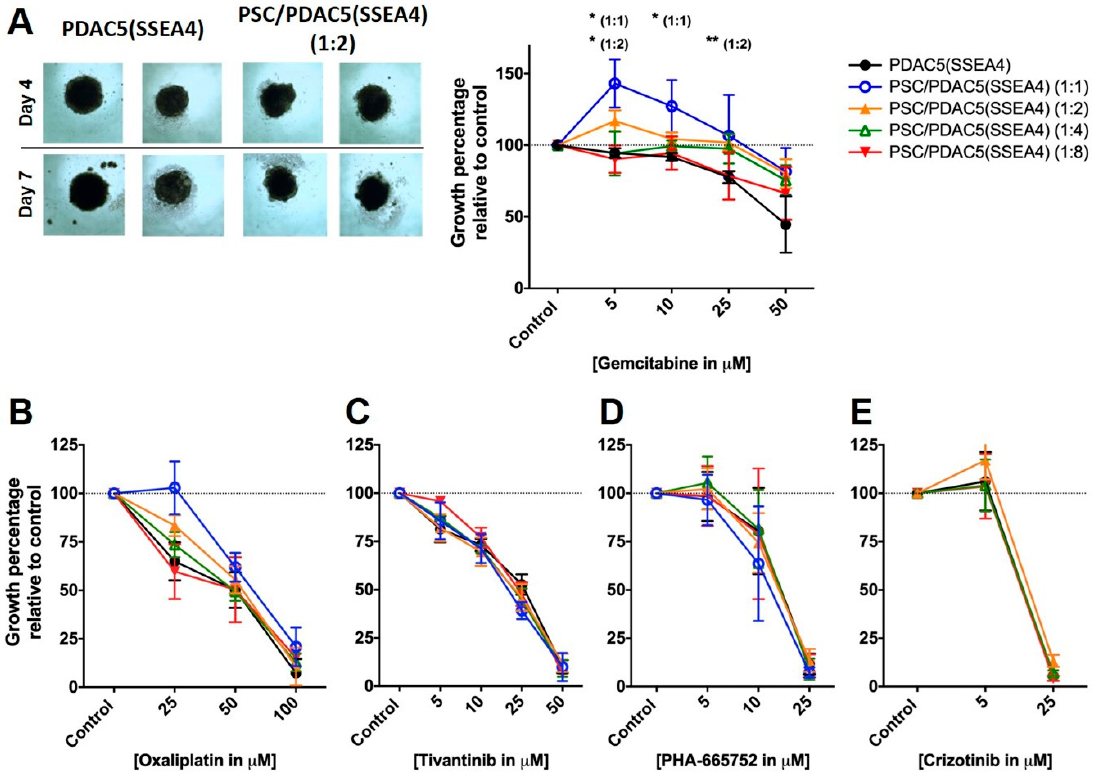
Figure 6. Drug response in homo-spheroids [primary PDAC5 cells sorted for SSEA4 (PDAC5 (SSEA4)] and hetero-spheroids [PSC/PDAC5 (SSEA4)] as determined by luciferase assay. PDAC5 (SSEA4) cells alone or mixed with immortalized PSCs at different ratios were grown in 96-well cell repellant plates to form homo- and hetero-spheroids, respectively. After 4 days of incubation, the spheroids were treated with different drugs and incubated for further 3 days as also shown in representative images of spheroids treated with gemcitabine taken on days 4 and 7, A left panel). The spheroids were treated with cytotoxic agents gemcitabine ( A ), and oxaliplatin ( B ) as well as c-MET inhibitors, tivantinib ( C ), PHA-665752 ( D ) and crizotinib ( E ) for 3 days and cancer cell proliferation was assessed by luciferase assay. The data represent the mean ± standard error of mean ( S.E.M.) of three to five experiments (* and **: the difference between the hetero-spheroid and homo-spheroid treated with same dose of drug was significantly different at p < 0.05 and p < 0.01, respectively). Abbreviations: PDAC: pancreatic ductal adenocarcinoma; SSEA4, stage specific embryonic antigen-4; PSC, pancreatic stellate cell.